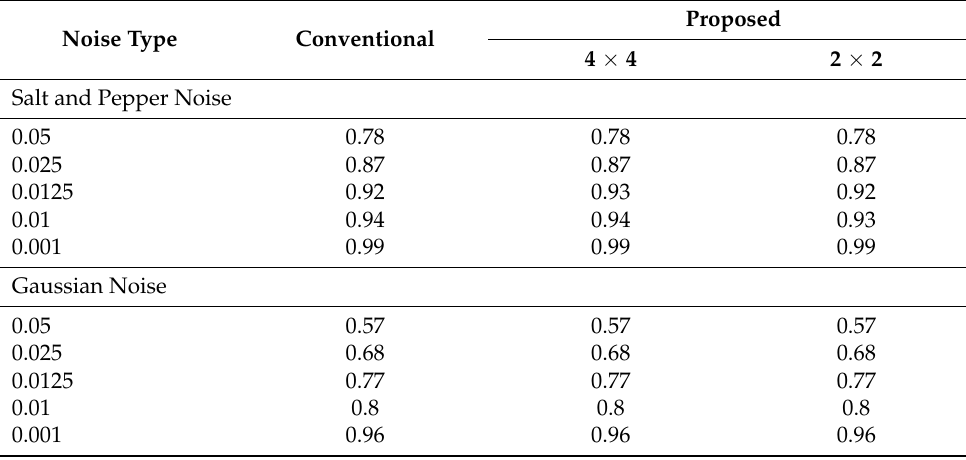
Table 4. Robustness analysis of perceptual encryption algorithms against salt and pepper noise and Gaussian noise. The image quality is in terms of MS-SSIM